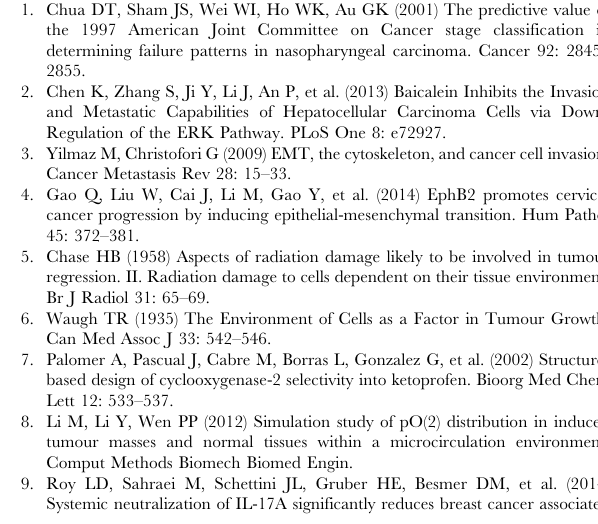
Figure S1 The effect of IL-17A on the apoptosis of NPC- 039 cells. The results showed that IL-17A did not affect the apoptosis of NPC-039